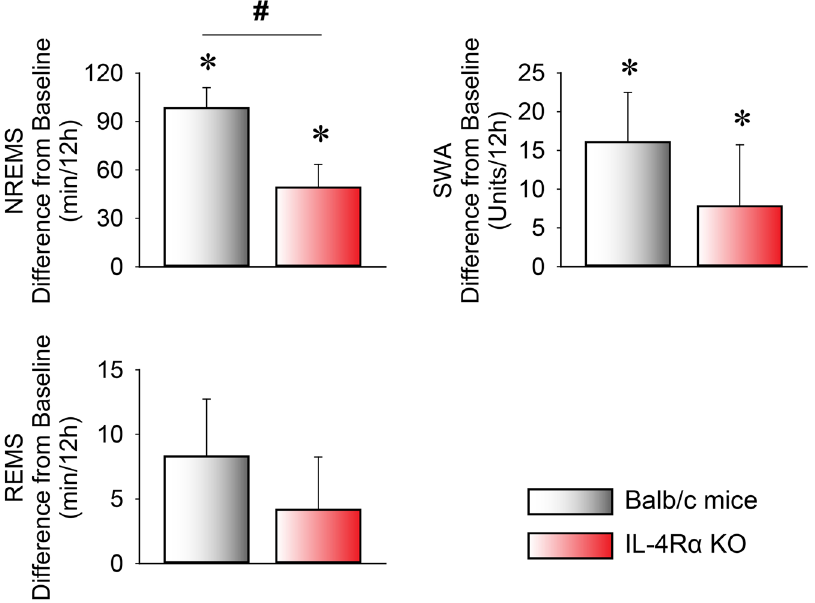
Figure 2. Changes in NREMS, REMS, and electroencephalographic slow wave activity (EEG SWA) during the 12-h dark period following sleep deprivation in WT (white bars) and IL-4R α KO (red bars) mice at an ambient temperature of 30 °C. Data are calculated in 12-h time blocks, as differences from the baseline. Error bars represent SEM. * Significant difference from baseline (paired t -test, p < 0.05), # significant difference between genotypes (Student’s t -test, P < 0.05).